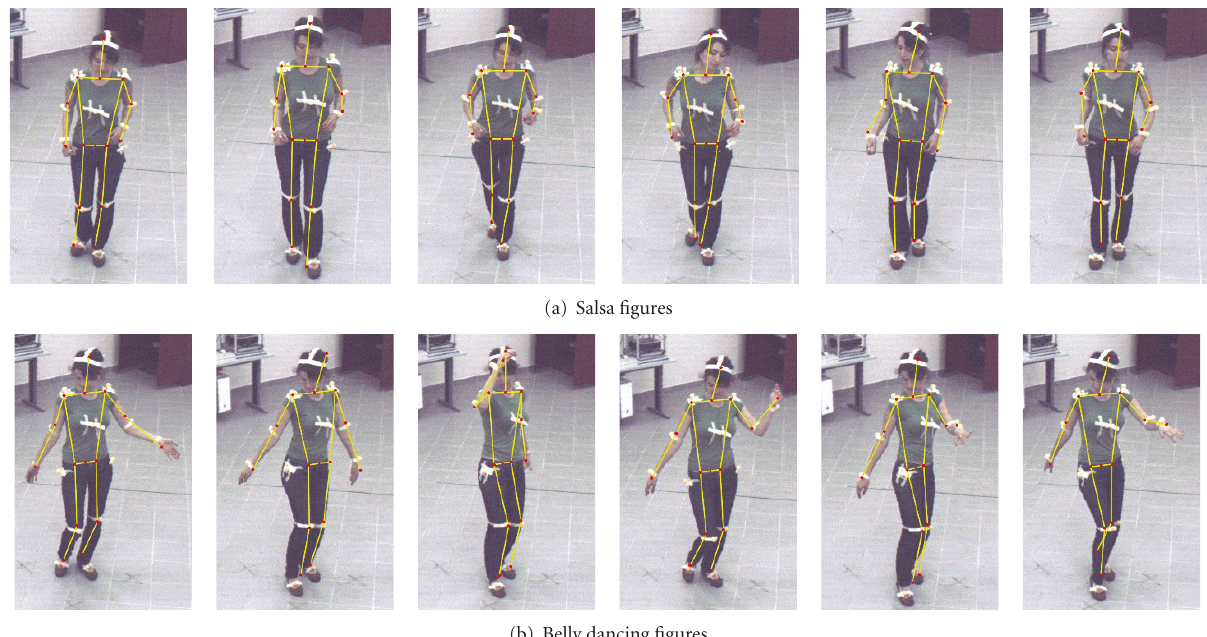
Figure 7: Dance motion tracking results. Two examples of dance tracking: salsa and belly